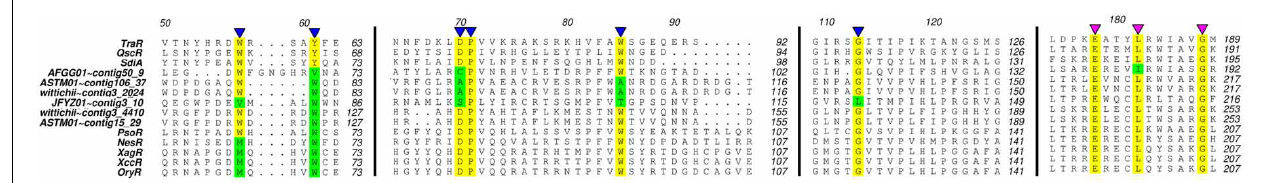
FIGURE 4 | Alignment of plant associated bacteria solos. LuxR solos and selected sphingomonad LuxR homologs. Number above the alignment corresponds to the residue number of the TraR protein. Regions highlighted in yellow indicate the invariant sites of canonical